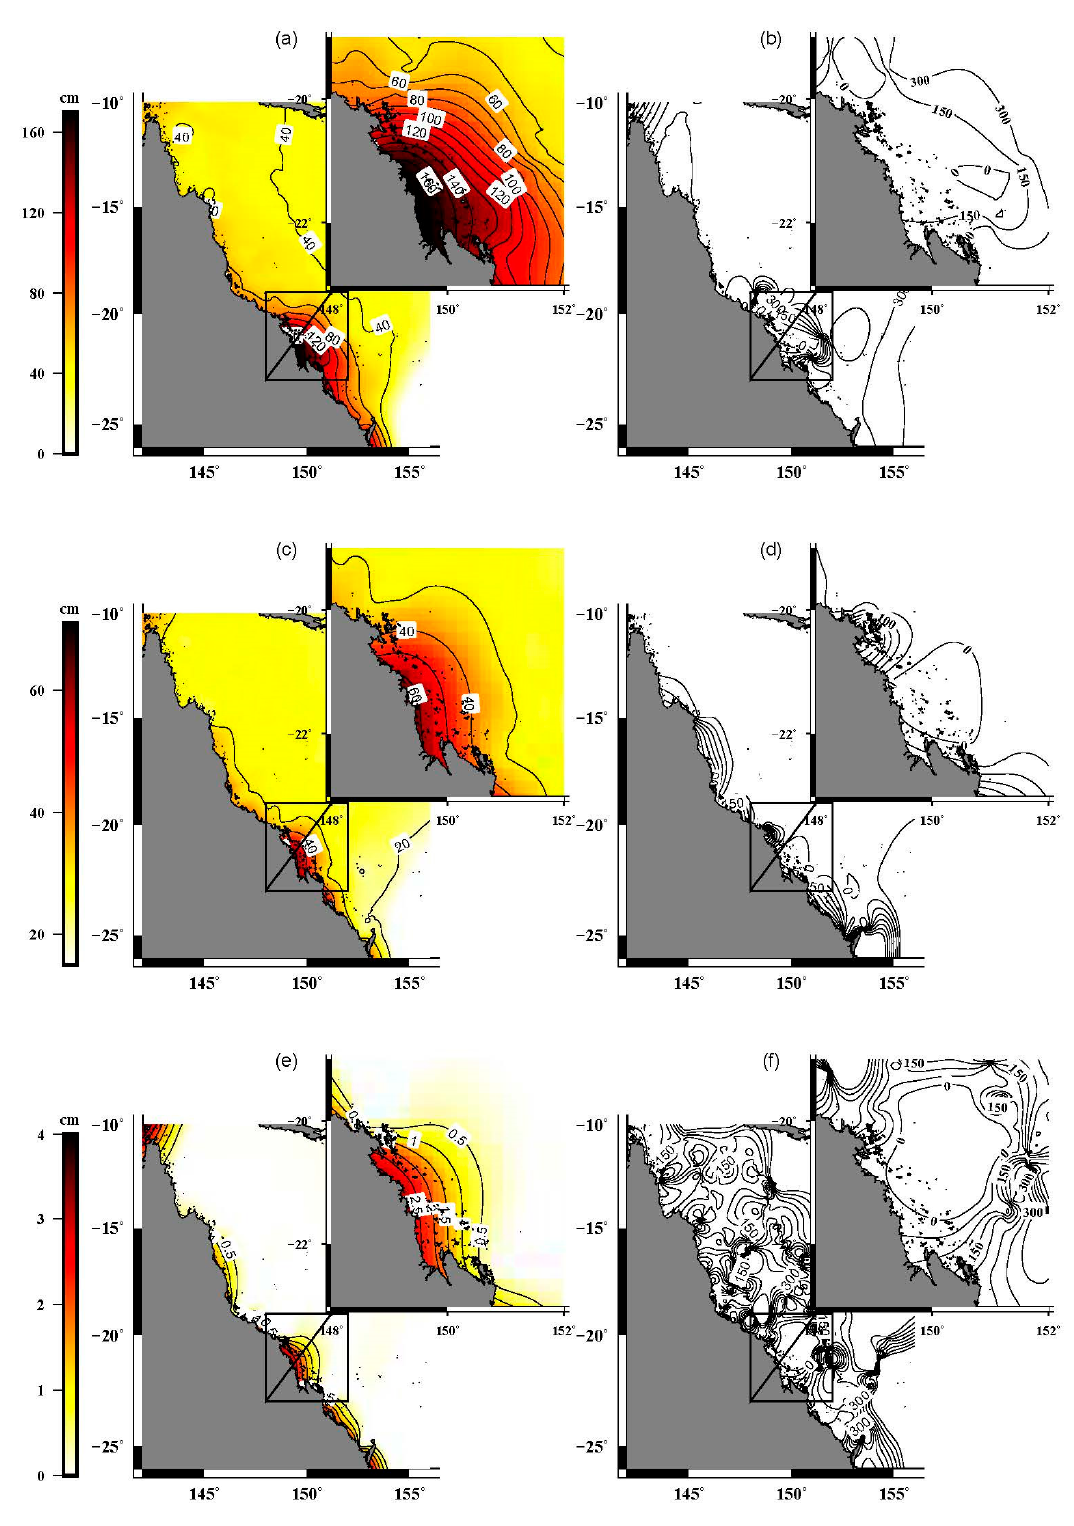
Figure 3. Co-range (in cm) maps of: M 2 ( a ); K 1 ( c ); and M 4 ( e ); and co-phase (in degrees) maps of: M 2 ( b ); K 1 ( d ); and M 4 ( f ) over